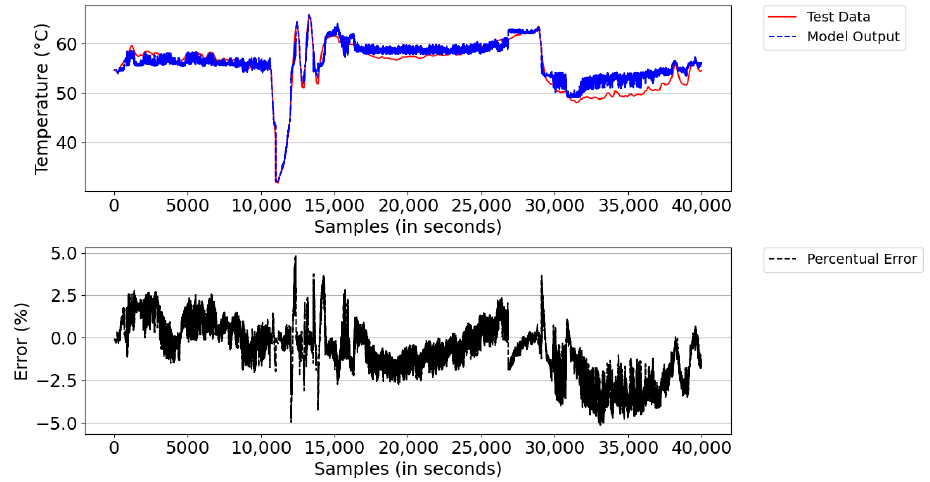
Figure 18. Model result versus actual Tout _ HT value and instantaneous percentage